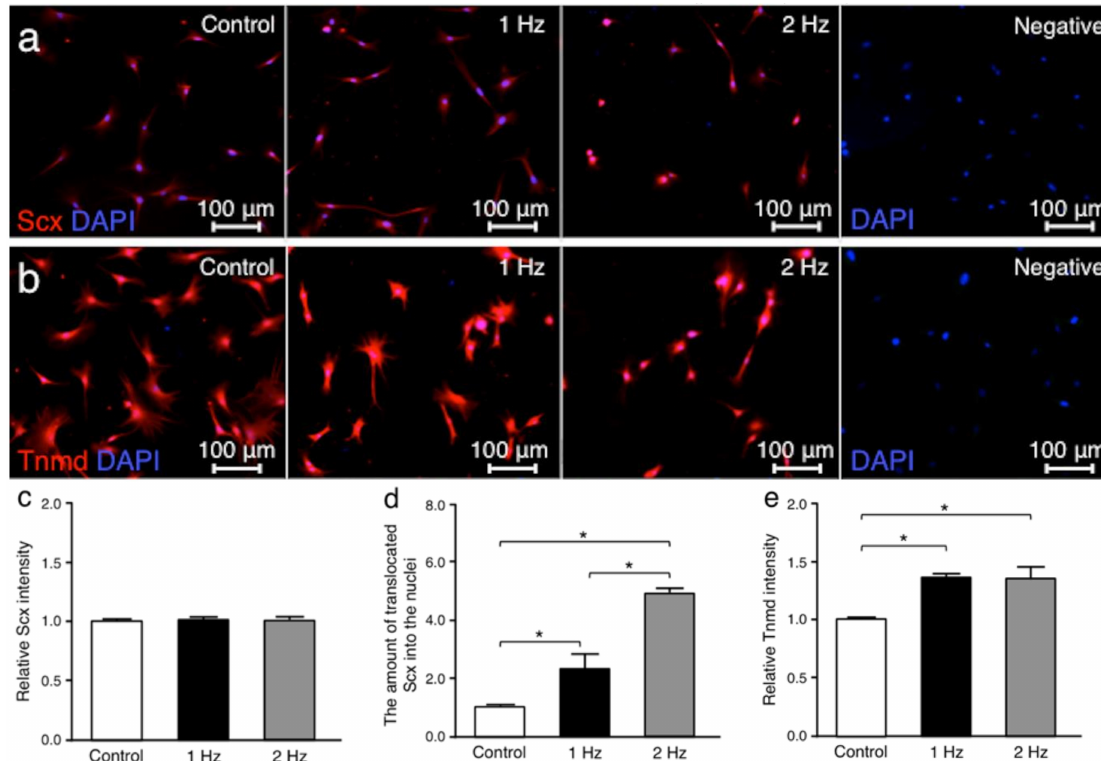
Figure 3. Scleraxis (Scx) and tenomodulin (Tnmd) fluorescence staining in overlay with nucleus coloration at di ff erent tensile frequencies. Comparison of representative immunofluorescence-labelings of Scx (red) ( a ) and Tnmd (red) ( b ) among the three groups: tenocytes cultured without stretching (control), with stretching at 1 Hz, and with stretching at 2 Hz. For negative control, primary antibody was omitted. 5% stretch was applied for 3 h. The intensities of Scx ( c ), the amount of translocated Scx into the cell nuclei ( d ), and Tnmd ( e ) were compared among the three groups. Nuclei were counterstained with DAPI (blue). The values of control were set to 1 ( n = 6; mean + SEM). * p < 0.05 indicates significance. SEM, standard error of the